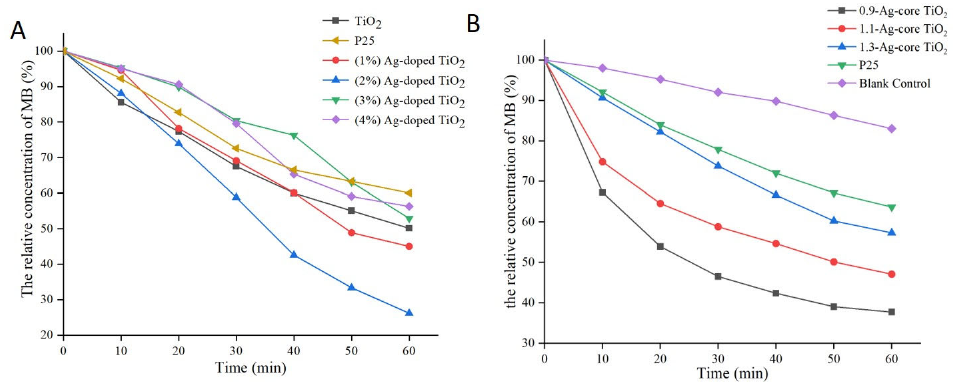
Figure 3. The photocatalytic degradation of methylene blue (MB) induced by Ag-doped TiO 2 ( A ) and Ag-core TiO 2 ( B